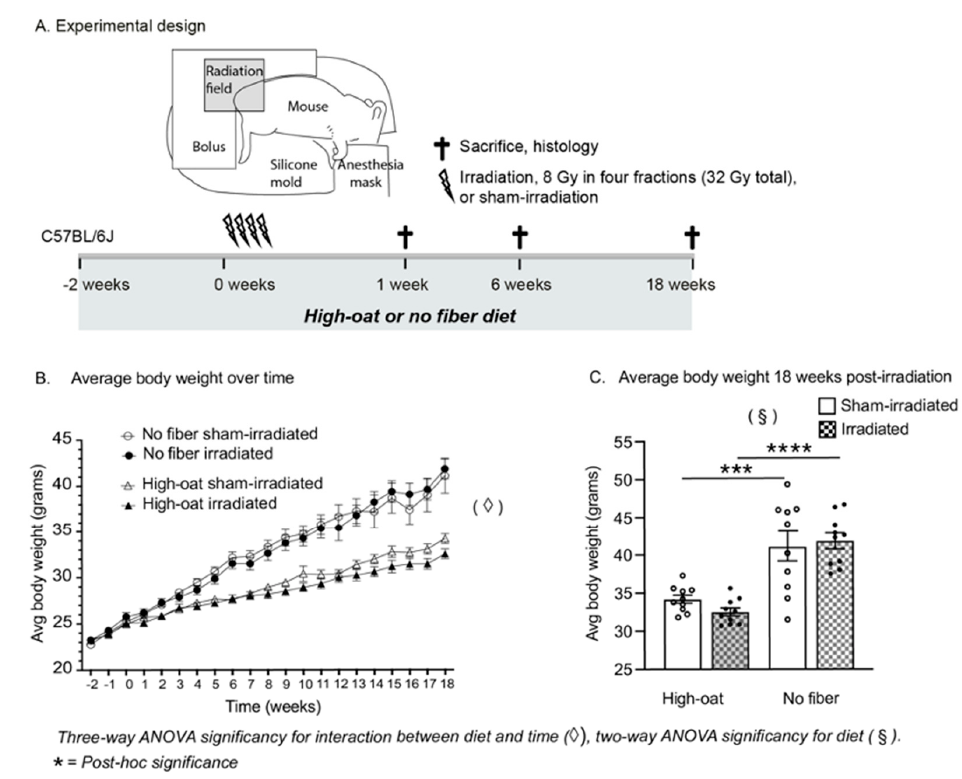
Figure 1. ( A ). Experimental design: 9 week old male C57BL/6J mice were fed either a fiber-rich bioprocessed oat bran diet (“High-oat”) or a fiber-deprived diet (“No fiber”) for two weeks before irradiation or sham-irradiation. During irradiation, 32 Gray was given to the colorectum with a 6 MV linear accelerator, in four fractions of 8 Gy spaced by 12 h. The diets were continued throughout the experiment, and mice were euthanized 1 week (acute time point), 6 weeks (intermediate time point) or 18 weeks (late time point) after irradiation. The colorectal tissues were harvested for the collection of various metrics on injury and repair. ( B ). Weight curves of mice during the 20 weeks of the dietary intervention and up to 18 weeks after irradiation. Fiber-deprived mice gained more weight over time than mice fed with bioprocessed oat bran ( p < 0.0001 for interaction between time and diet). ( C ). At 18 weeks after irradiation, mice on a fiber-free diet had gained significantly more weight than mice on a fiber-rich diet, and irradiation did not affect their weight gain.*** p < 0.0006, **** p < 0.0001. Data are shown as mean ± S.E.M.